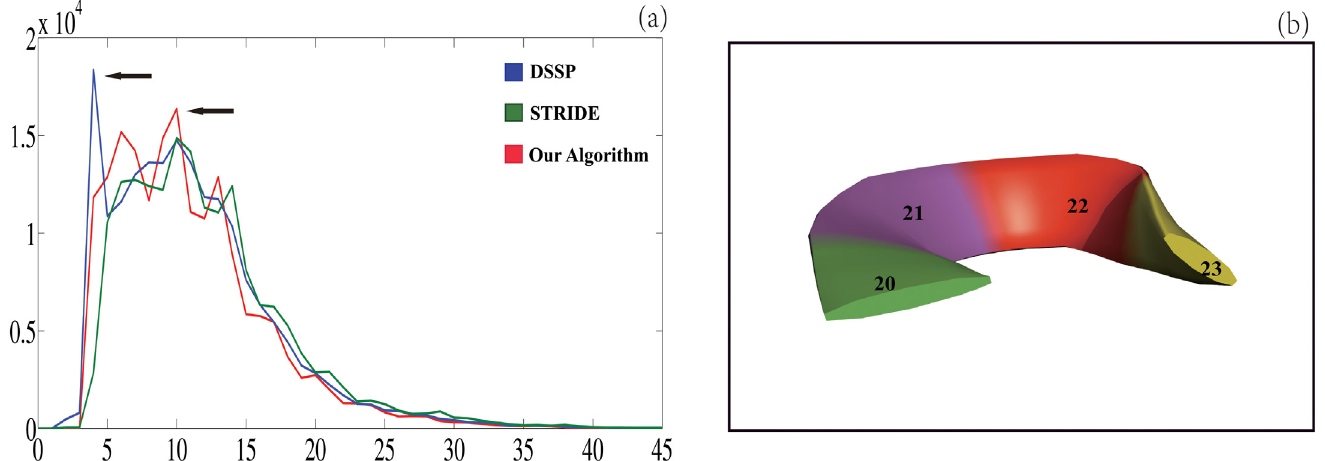
Fig 3. The distributions of the lengths of the α -helices from our algorithm, DSSP and STRIDE (a), and an example of 4-residue α -helix by DSSP (b). The x- axis in (a) is the helix length while the y-axis is the number of the helices with that particular length. The two arrows point to the most frequently appeared helices assigned by DSSP and by both our algorithm and STRIDE . The right figure (b) depicts a DSSP -assigned 4-residue α -helix in a protein (pdbid 1CC5) that is not assigned to a helix by our